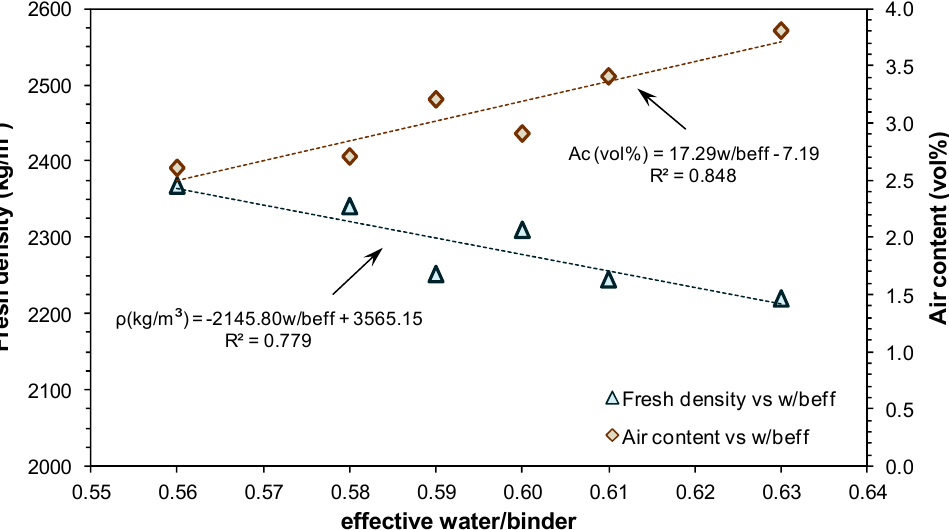
Figure 2. Fresh-state density and air content as a function of the w/b eff ratio.